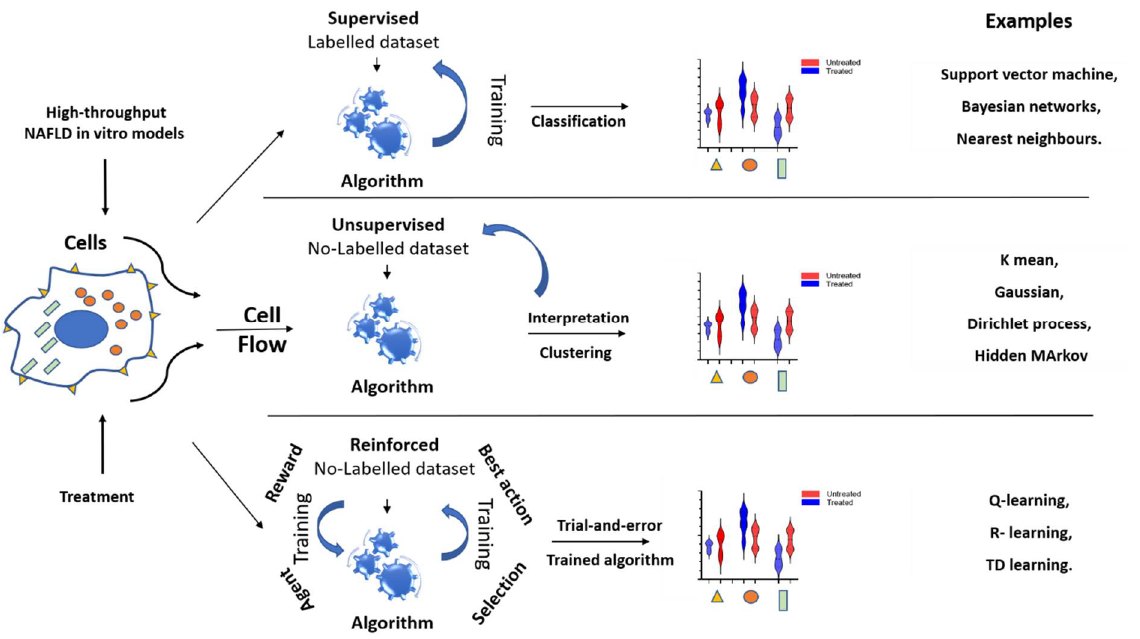
Figure 6. Supervised, Unsupervised, and reinforced learning applications for